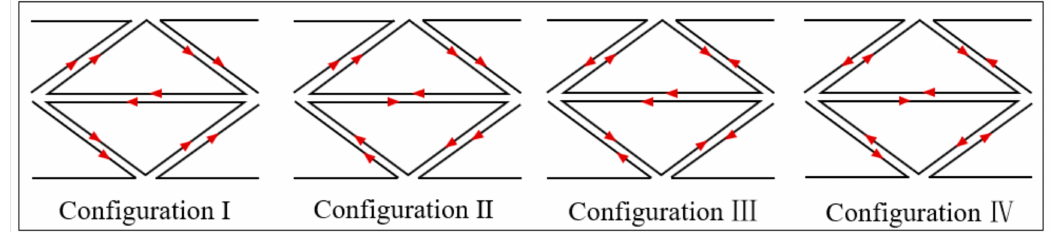
Figure 4. Four exciting configurations.